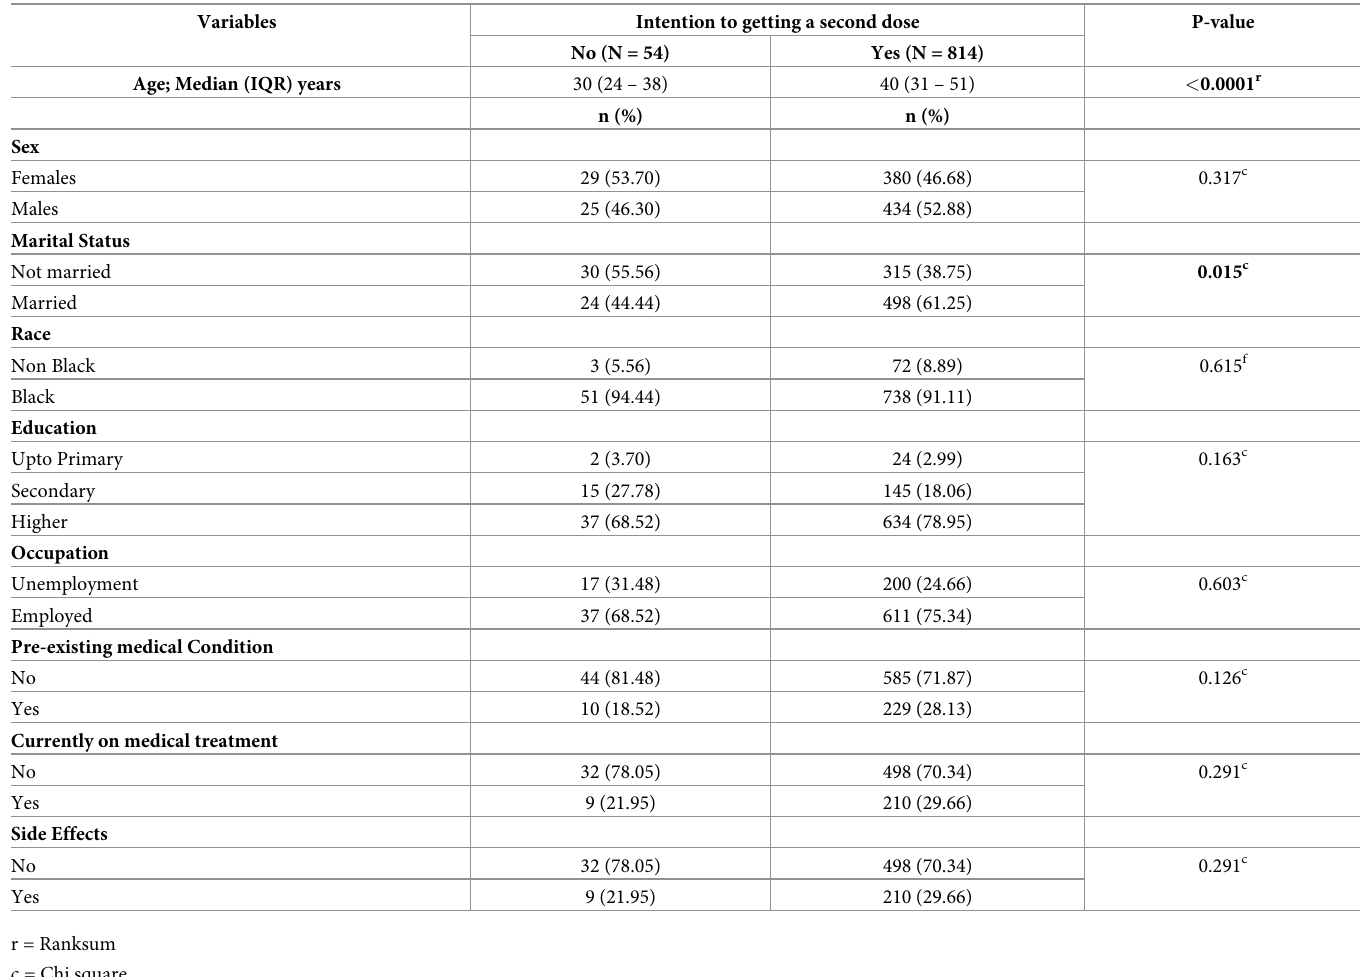
Table 2. Characteristics of participants and intention to getting a second dose of AstraZeneca